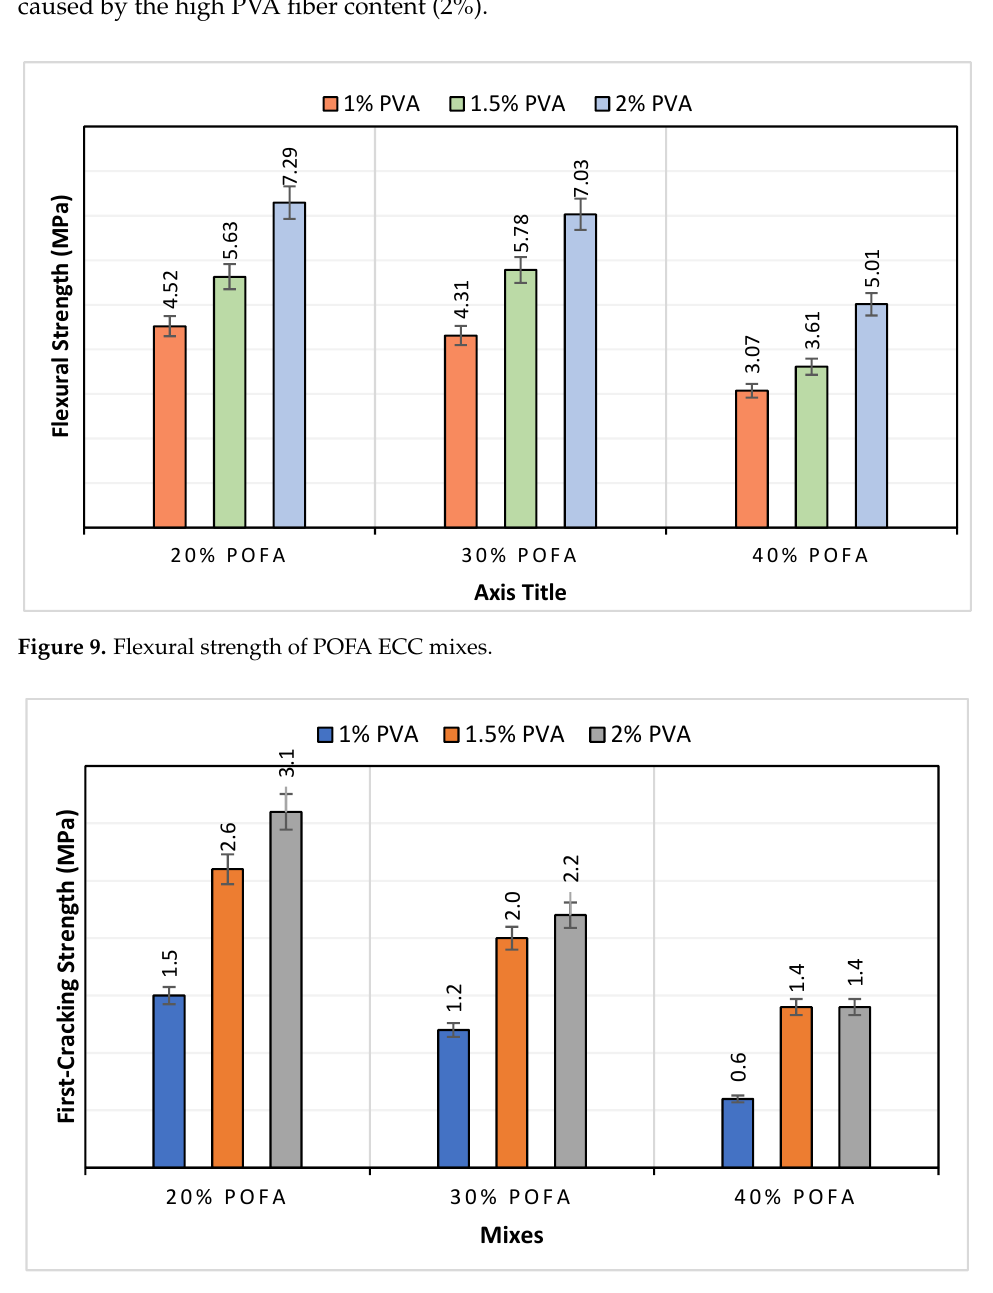
Figure 11. Load-deflection curves for POFA-ECC mixes . 3.4. Microstructural Properties of POFA-ECC To obtain more insight into the microstructural properties of the POFA-ECC, Field Emission Scanning Electron Microscopy (FESEM) was performed on some selected mixes. The FESEM micrographs show the presence of more unreacted POFA in mixes with higher POFA replacements, which is due to the slow pozzolanic reaction and the dilution effects, as explained earlier. Furthermore, due to the porous nature of the POFA particles, as shown in Figure 12a, at higher POFA contents, most of it remained unreactive in the composite, as shown in Figure 12b, causing a reduction in the toughness and strength of the composites. This is contrary to mixes having lower POFA content, as shown in Figure 12c. Similarly, a micrograph of mixes with higher PVA fiber contents shows how the fibers could tangle together to cause a reduction in the compressive strength due to poor bond- ing with the paste, as indicated in Figure 12d.